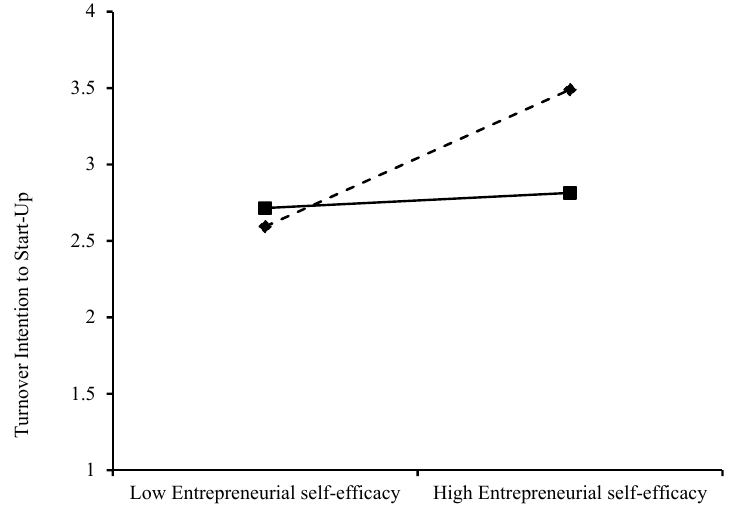
Figure 3. Diagram of the regulation effect.